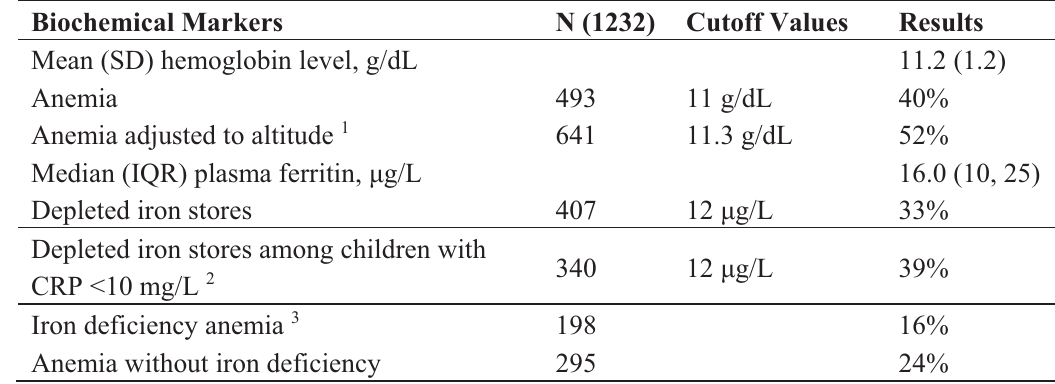
Table 2. Mean hemoglobin and plasma levels of ferritin and prevalence of anemia and iron deficiency among children aged 6 – 35 months with acute diarrhea in Bhaktapur,